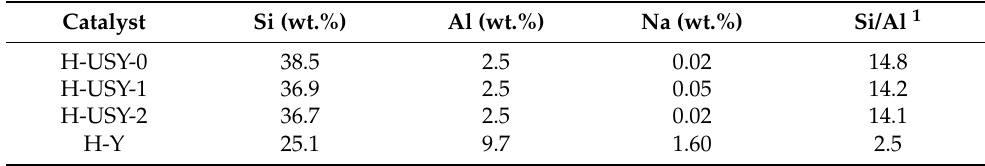
Table 3. Elemental composition by ICP-OES and Si/Al ratio. Catalyst Si (wt.%) Al